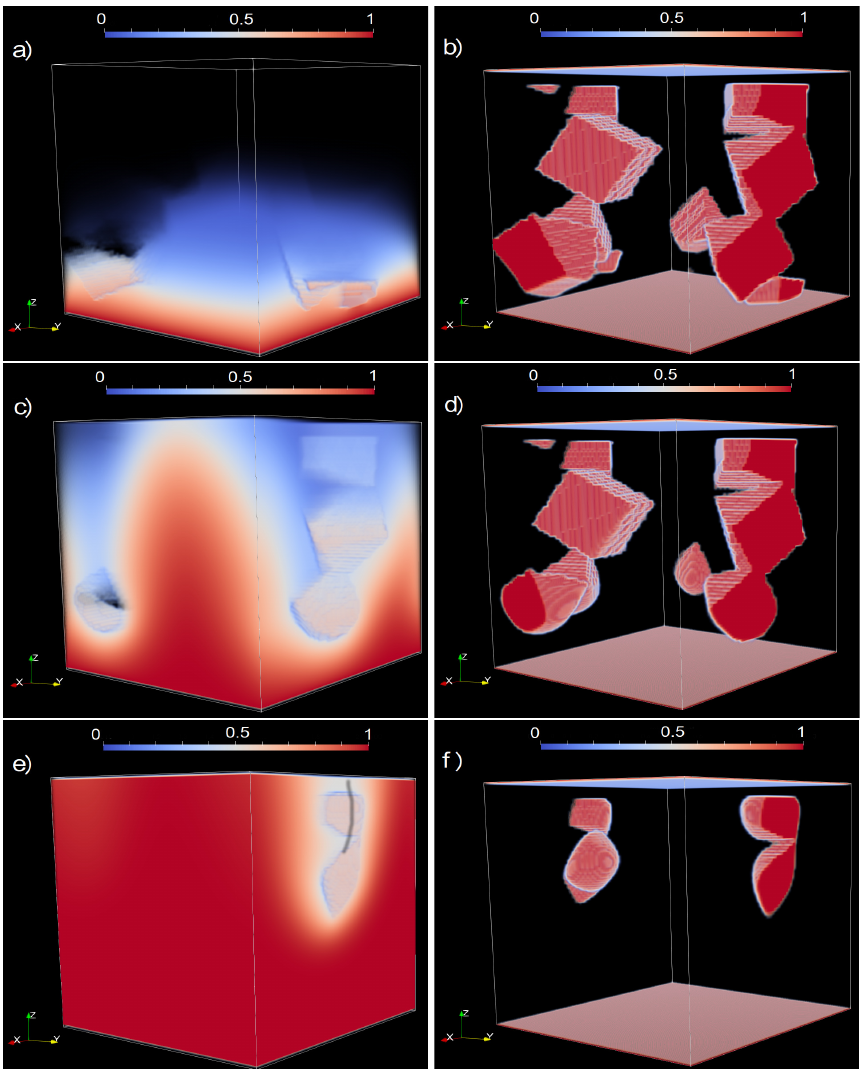
Figure 5. Solvent and mineral distributions at various stages during a small Peclet number (Pe = 0.1) flow. ( a ) Solvent concentration at initial stages, ( b ) mineral content at initial stages, ( c ) solvent concentration at middle stages, ( d ) mineral content at middle stages, ( e ) solvent concentration at final stage, and ( f ) mineral content at final